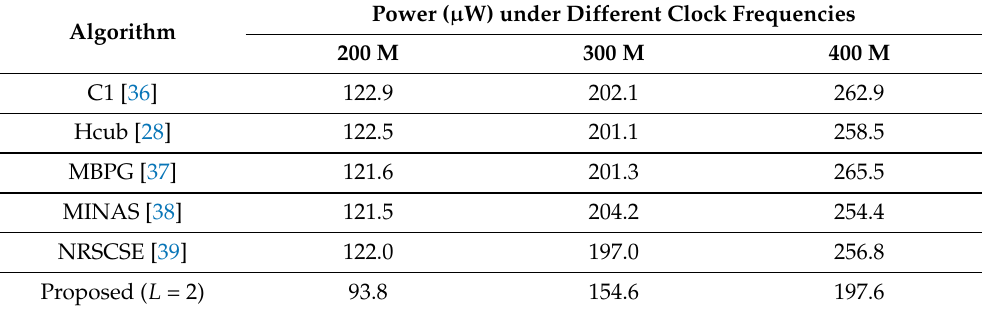
Table 5. Power comparison of the 418-tap filter with a 12-bit word-length (40 nm CMOS